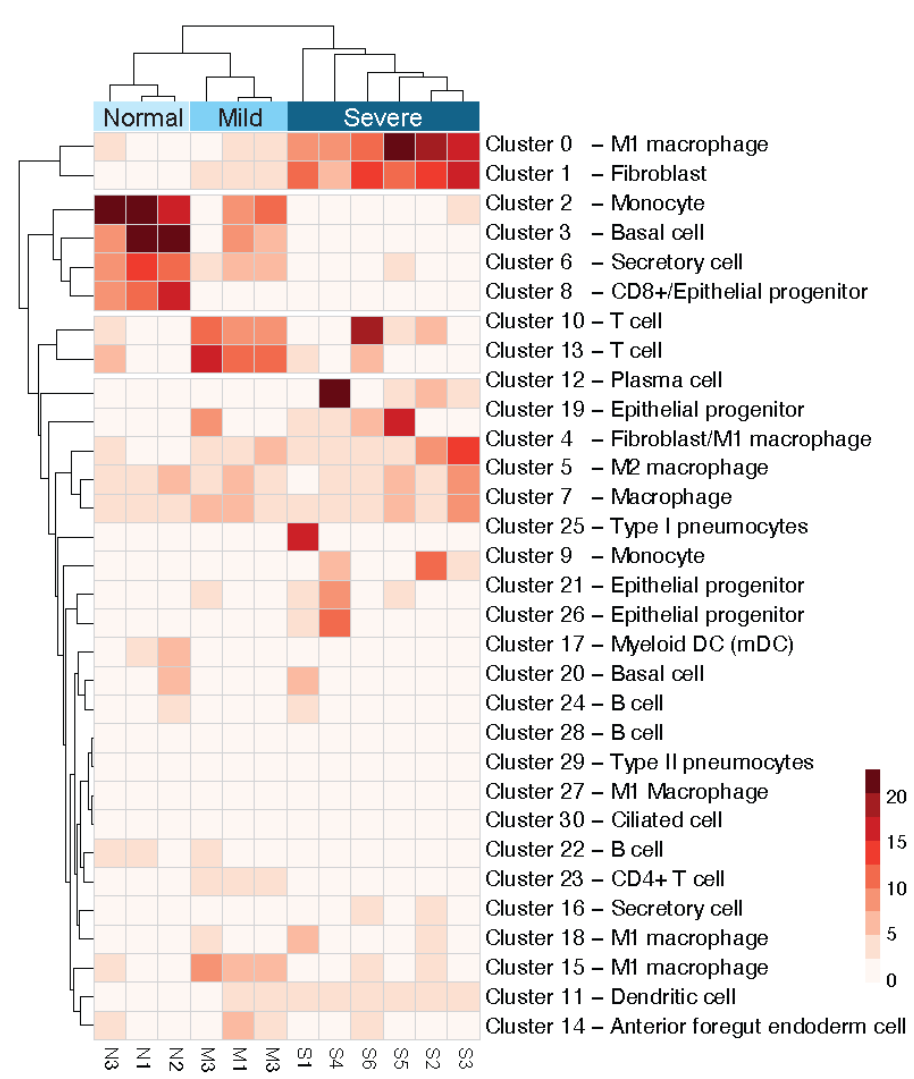
Figure 3. Clustergram of the percentage of cells in each cluster from each patient and their COVID-19 infection severity. The X -axis displays the patients where normal, mild, and severe symptoms patients are clustered together. The Y -axis shows the 31 clusters numbered from 0 to 30 and the corresponding cell types assigned. Clusters get darker red in the heatmap where there is a higher percentage of cells that belong to a specific patient.